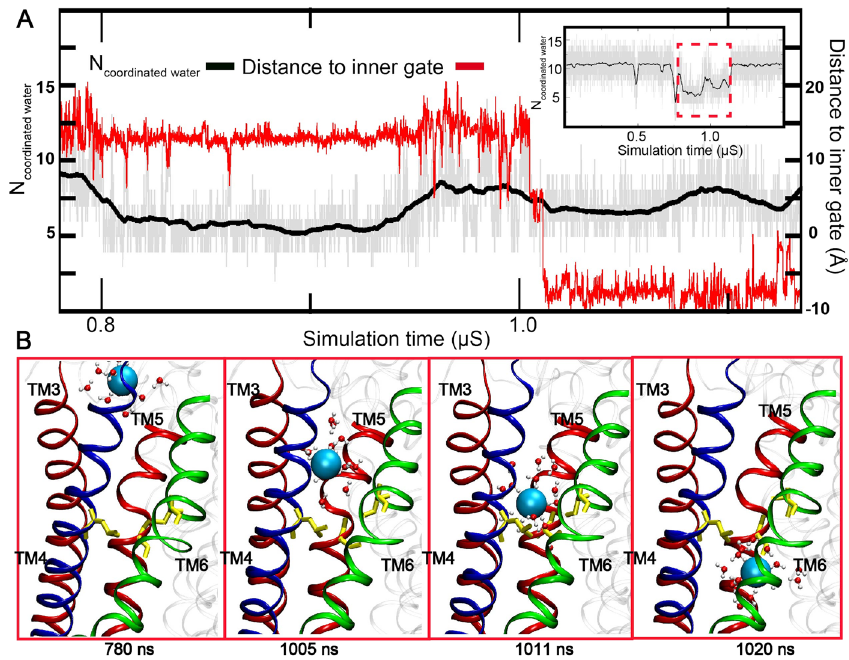
Fig. 3 Spontaneous permeation of Cl − through the TMEM16A pore. A Number of coordinating waters of permeating Cl − and its distance to the inner gate during the event (780 – 1030 ns of sim 3 ). The insert shows the hydrating water number of the same Cl − ion in the whole simulation with the spontaneous permeation event highlighted by a dashed red box. B Representative snapshots during permeation. TMs 3 and 5 are represented as red cartoons and TMs 4 and 6 are colored in blue and green, respectively. The inner gate residues (L547, S592, and I641) are shown in yellow sticks. The permeating Cl − ion is represented as a cyan sphere, with water molecules within 4 Å shown in the ball-and-stick mode.